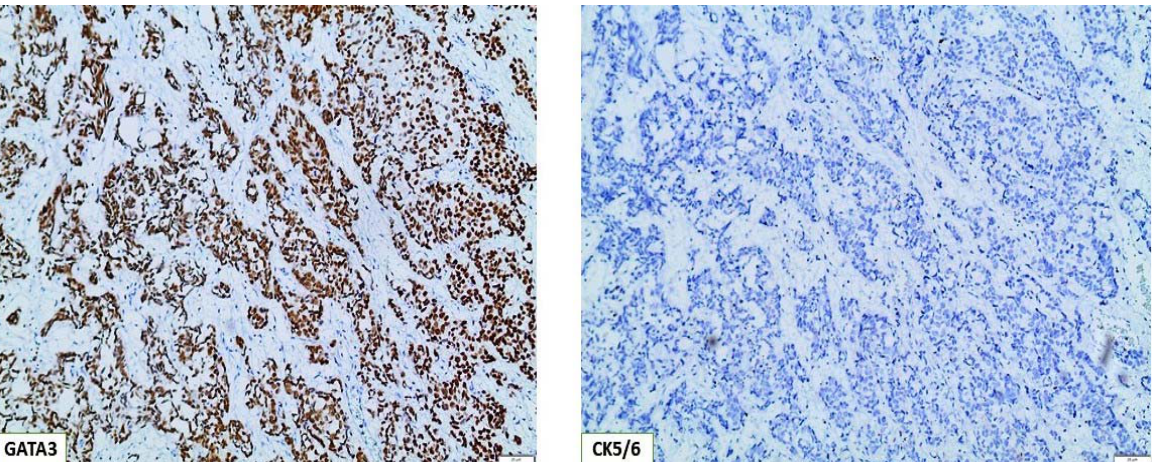
Figure 4. Molecular classification of basal type bladder tumors, based on the immunohistochemical algorithm GATA3(+)/CK5/6( − ) (×100). Table 1. Clinicopathological features of obtained bladder cancer samples.